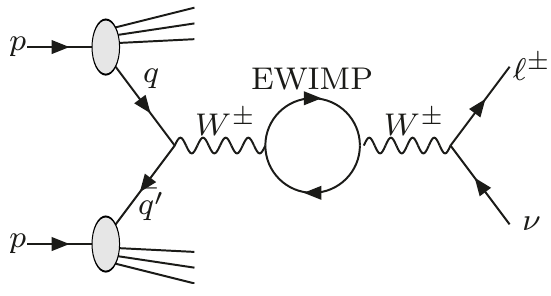
Figure 1 . Radiative correction from